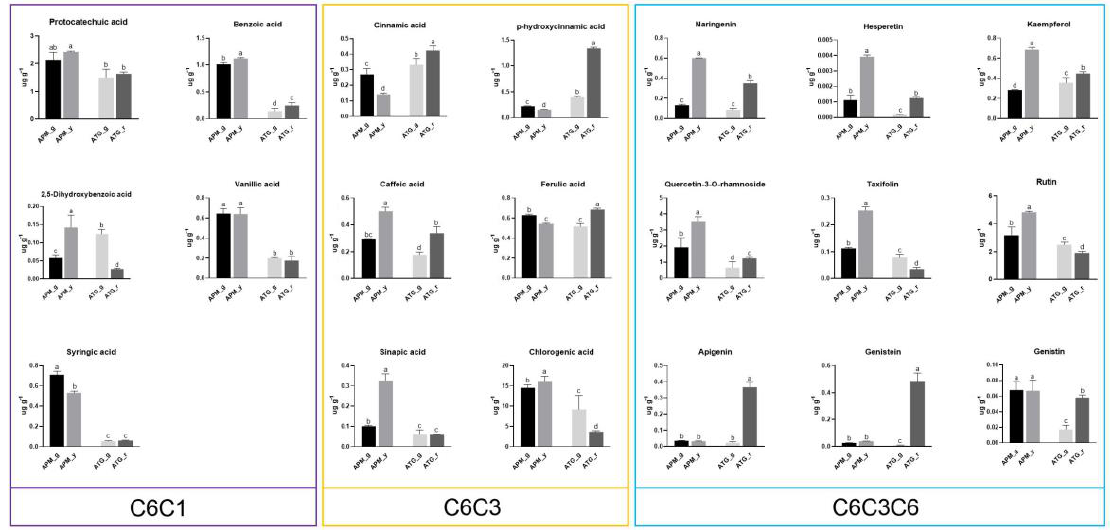
Figure 8. Content of different types of phenolic compounds in APM and ATG leaves in different seasons. Different letters indicate significant differences in different tissues ( p < 0.05).